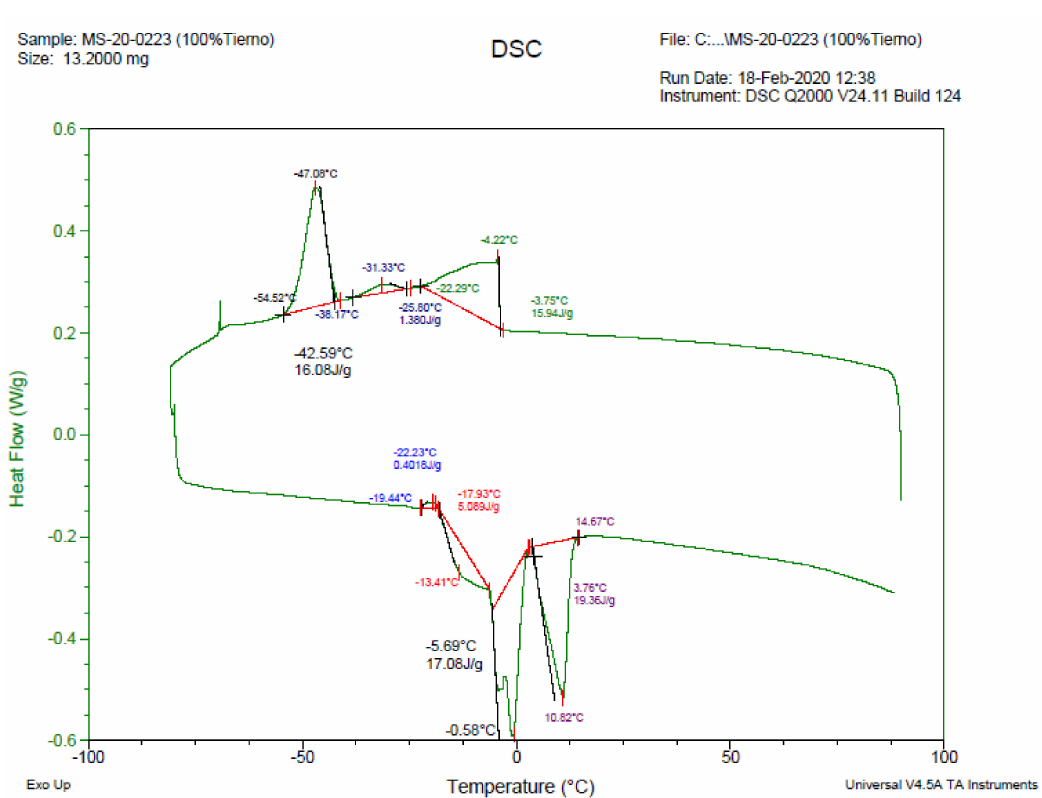
Figure A6. DSC Sample AA-100T.